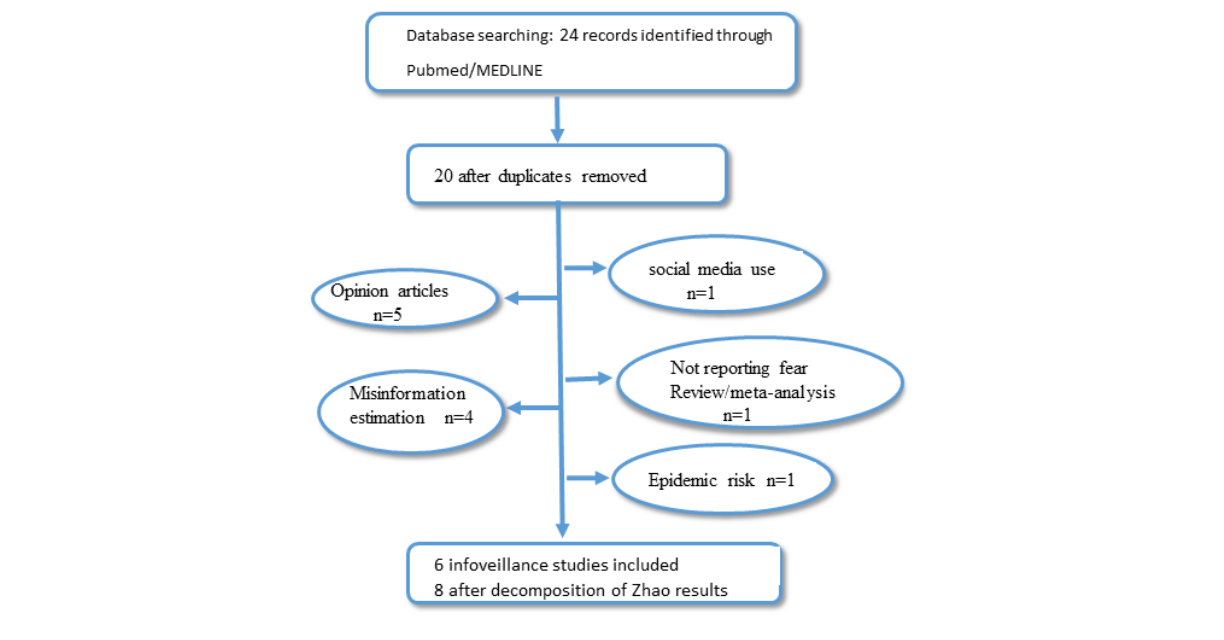
Figure 1. Flow chart.